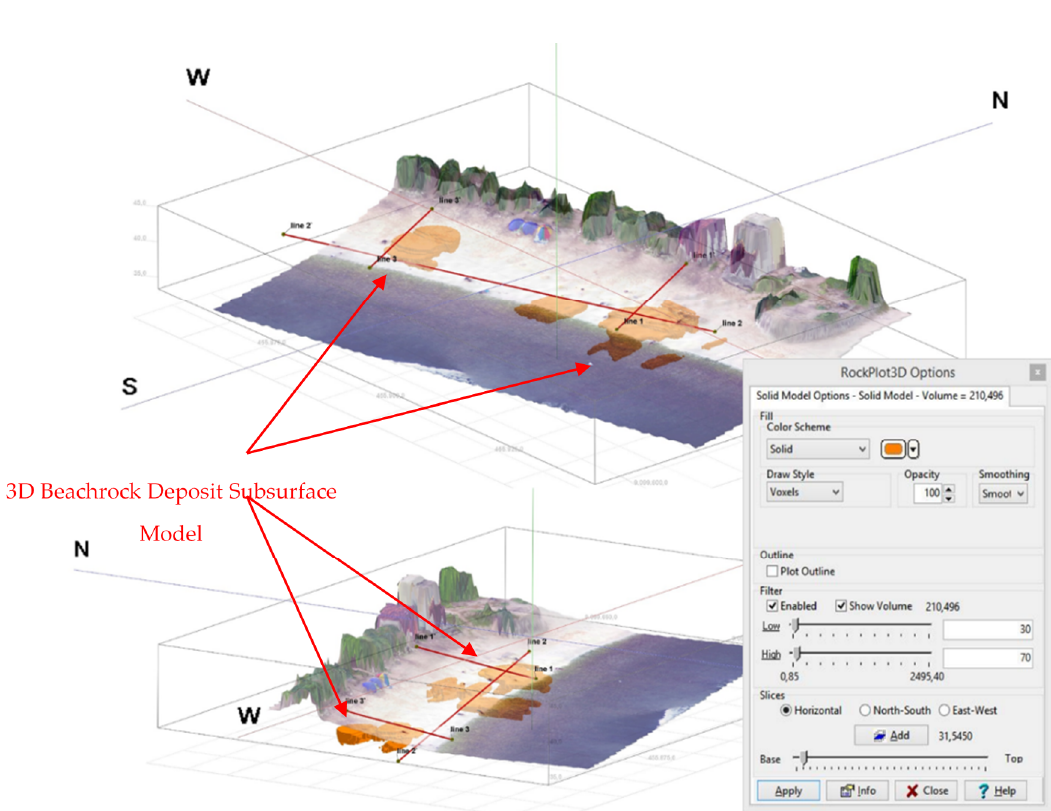
Figure 4. Three dimensional of beachrock model calculation based on geophysical statistical anomaly data from electrical resistivity and multi analysis surface wave of α-section.